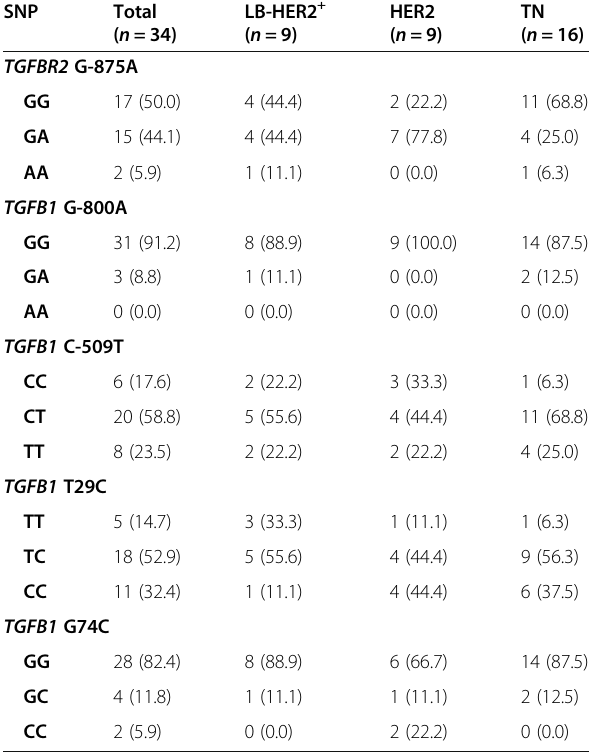
Table 2 Genotypes for TGFB1 and TGFBR2 of BC